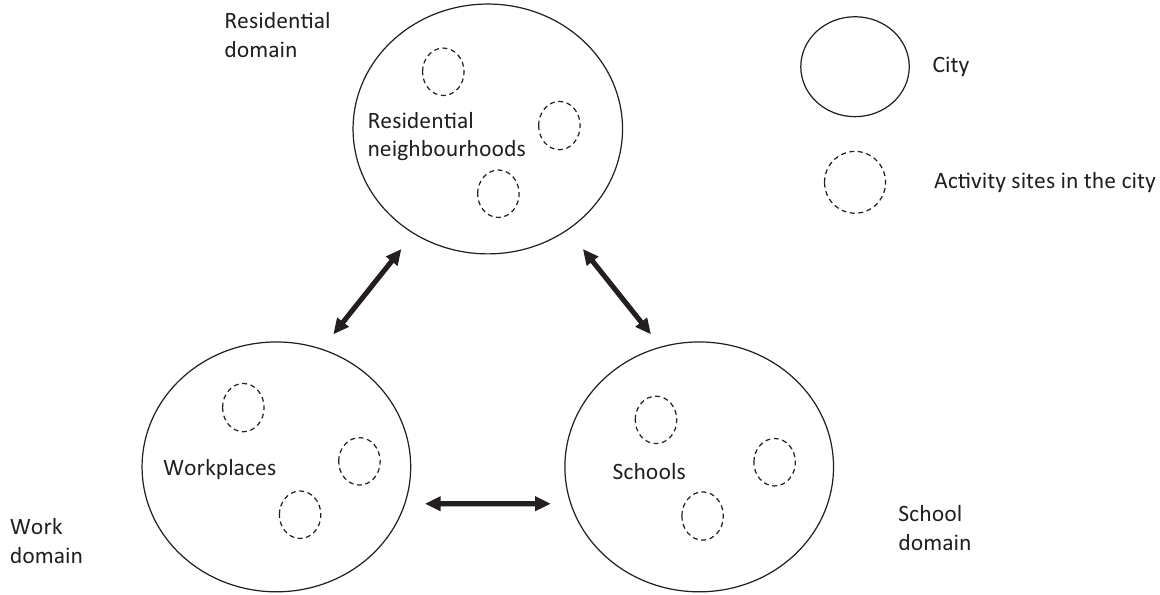
Figure 1. The connections between spatial inequalities in different life